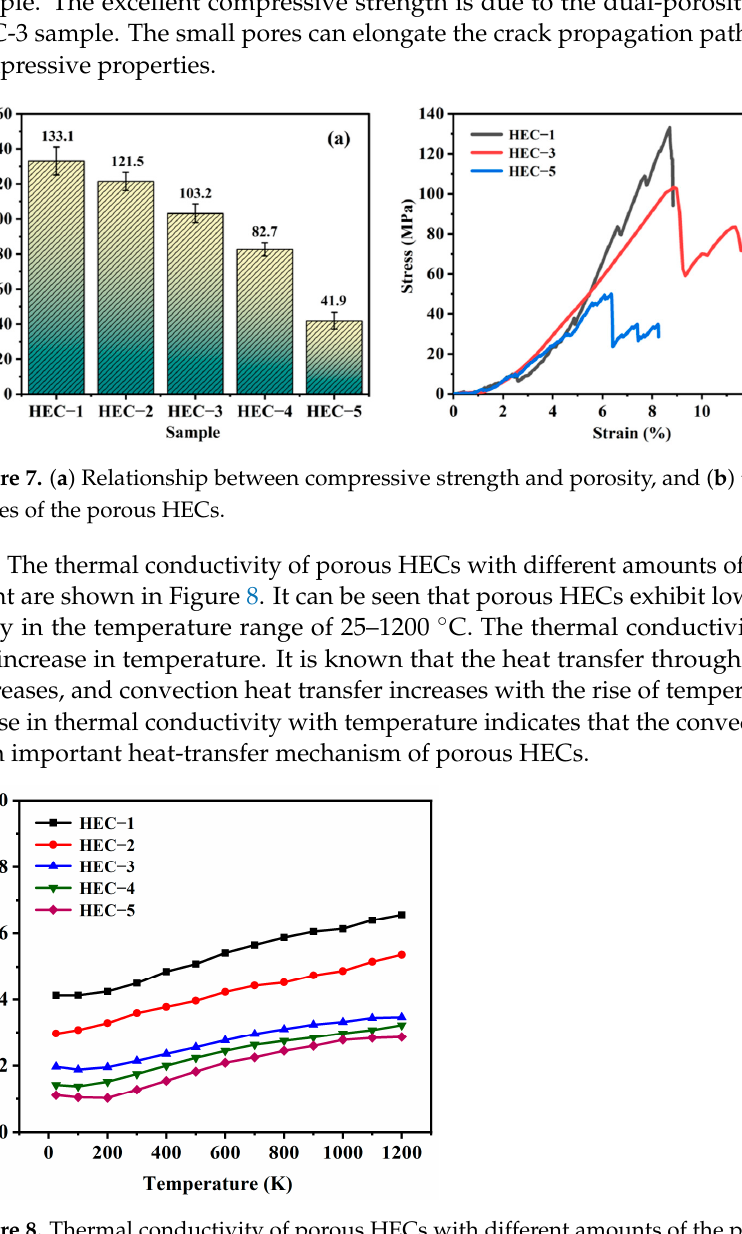
Figure 8. Thermal conductivity of porous HECs with different amounts of the pore-forming agent. The thermal diffusivity ( α ), specific heat ( C p ), and room temperature thermal conductivity ranges from 4.12 W · m − 1 k − 1 to 1.11 W · m − 1 k − 1 , which is lower than dense HECs (6.45 W · m − 1 k − 1 ) due to high porosity. Comparing the thermal conductivity